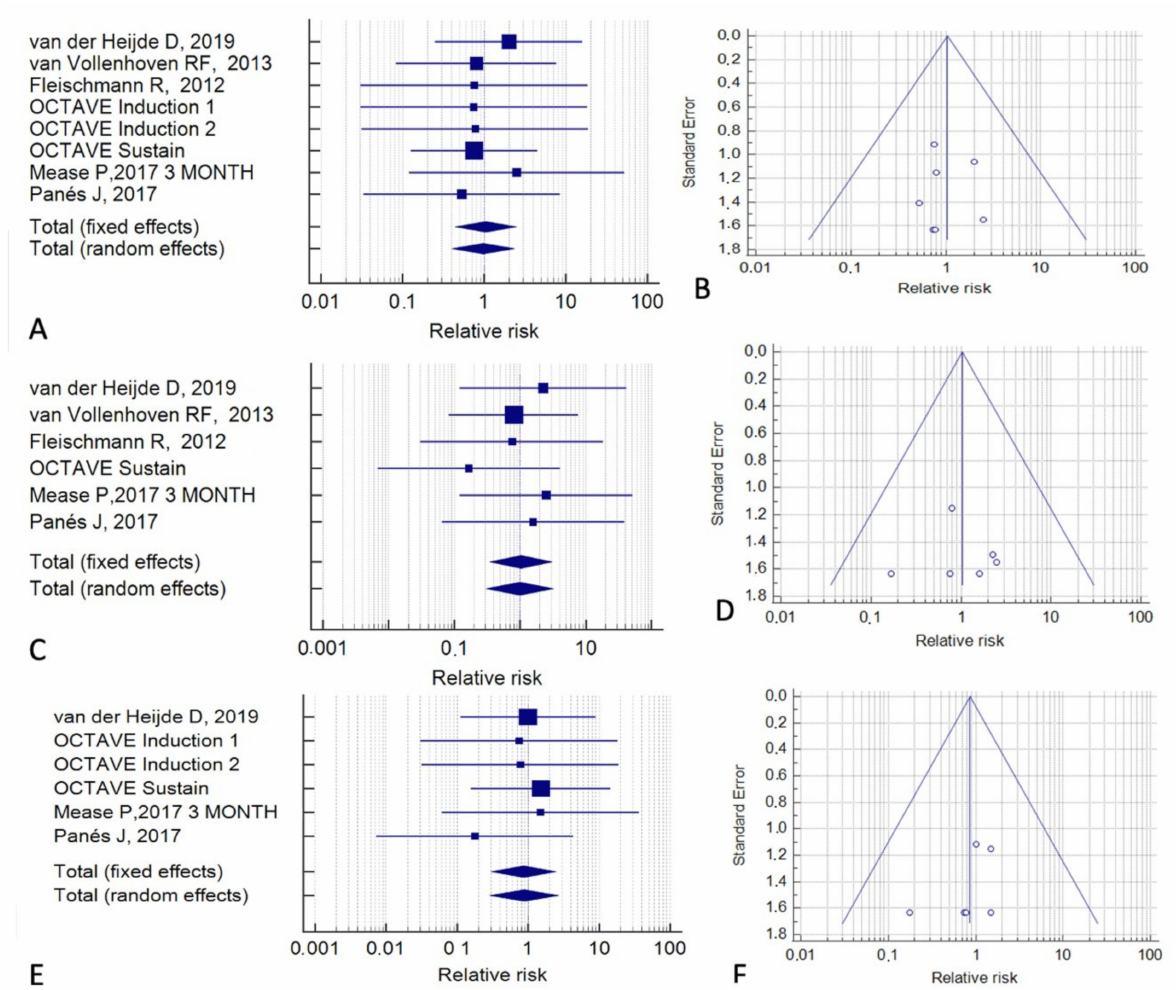
Figure 5. Risk of malignancy in tofacitinib-treated patients relative to placebo-treated patients. ( A , B ) All cancers. ( C , D ) All cancers except non-melanoma skin cancer. ( E , F ) Non-melanoma skin cancer. ( A , C , E ) Forest plots of relative risk. ( B , D , F ) Funnel plots for the assessment of publication bias [2,20,24,25,35,36,39].